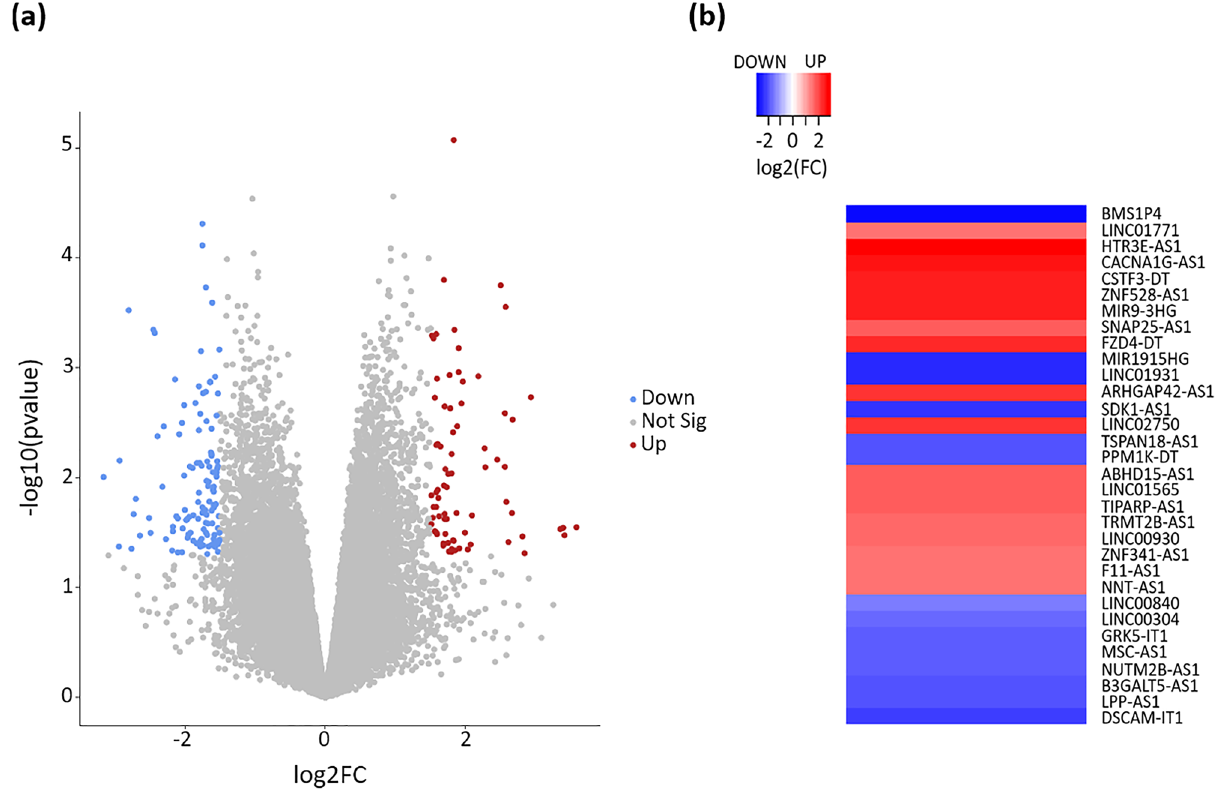
Figure 2. Differential expression signature of lncRNAs in prostate cancer. ( a ) Volcano plot shows the expression pattern of the lncRNAs in Prostate cancer. The red and blue dots indicate the significantly (p-value < 0.05) up-regulated (log2FC > 1.5) and down-regulated (log2FC < − 1.5) lncRNAs, respectively. ( b ) Heatmap shows the differentially expressed lncRNAs whose promoter region gets methylated differentially in Prostate cancer. The red and blue bars respectively represent the significantly (p-value < 0.05) up-regulated (log2FC > 1.5) and down-regulated (log2FC < − 1.5)